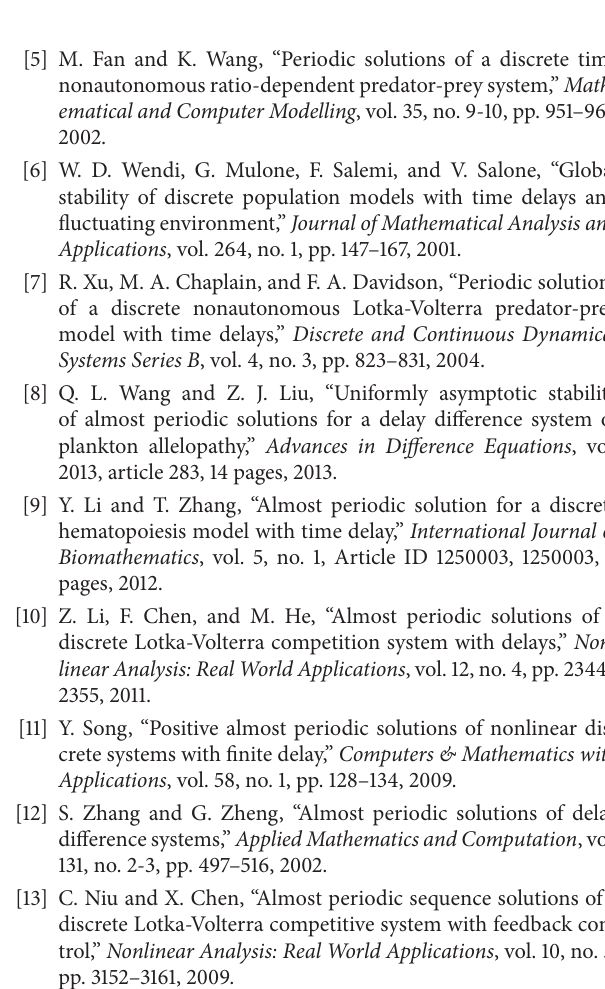
(𝑛) and 𝑥 (𝑛) with initial values 𝑥 + 2 2 (0) = 0.97 for 𝑛 ∈ [0,100] , 2